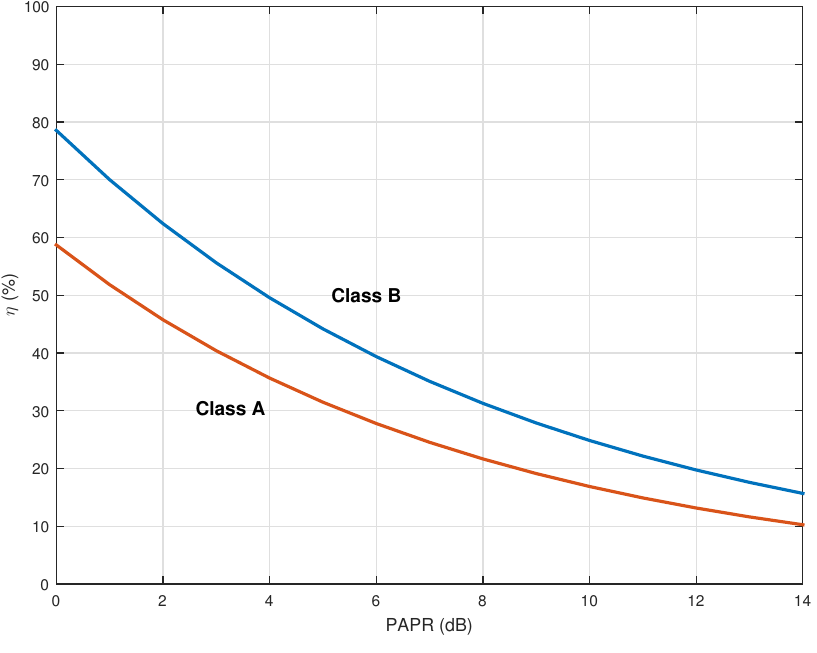
Figure 1. PA efficiency, η ( % ) versus PAPR(dB).